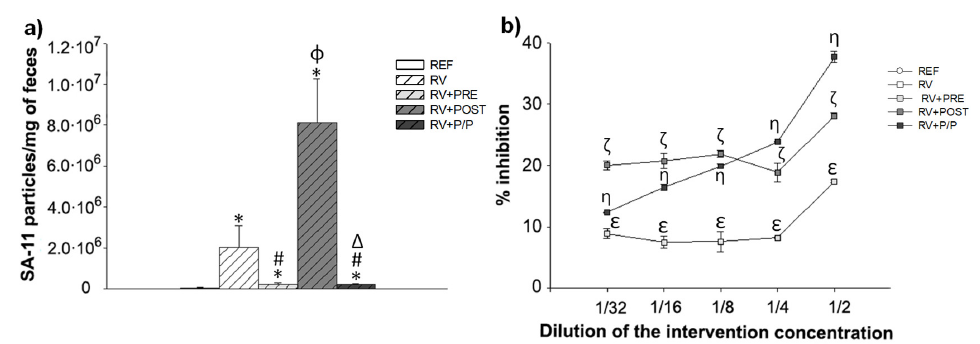
an in-house in vitro blocking assay ( b ). Results are expressed as mean ± SEM ( n = 24 animals/group). Statistical differences: * vs. REF, # vs. RV, ϕ vs. RV + PRE, Δ vs. RV + POST ( a ) and ε RV + PRE vs. RV, ζ RV + POST vs. RV, and η RV + P/P vs. RV ( b ). REF: reference group; RV: rotavirus group; RV + PRE: rotavirus group supplemented with a mixture of scGOS/lcFOS; RV + POST: rotavirus group supplemented with Lactofidus TM ; RV + P/P: rotavirus group supplemented with the combination of